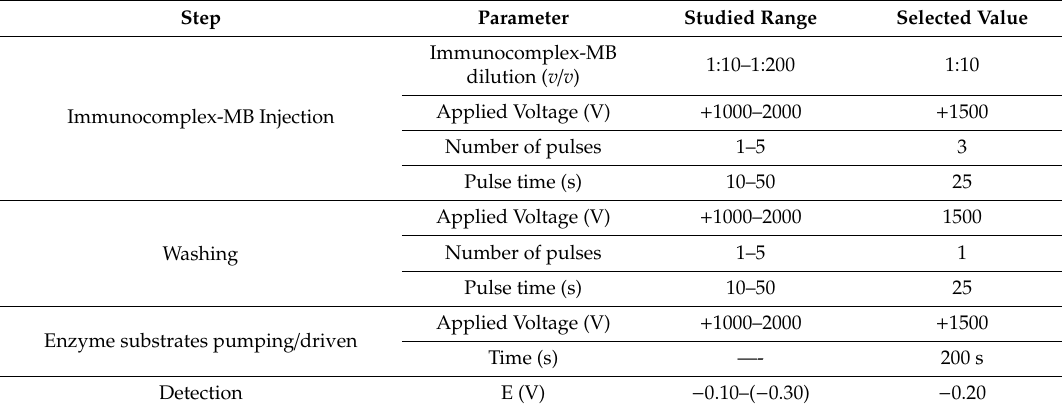
Table 1. Electrokinetics and electrochemical detection, EMC-Au optimizations.